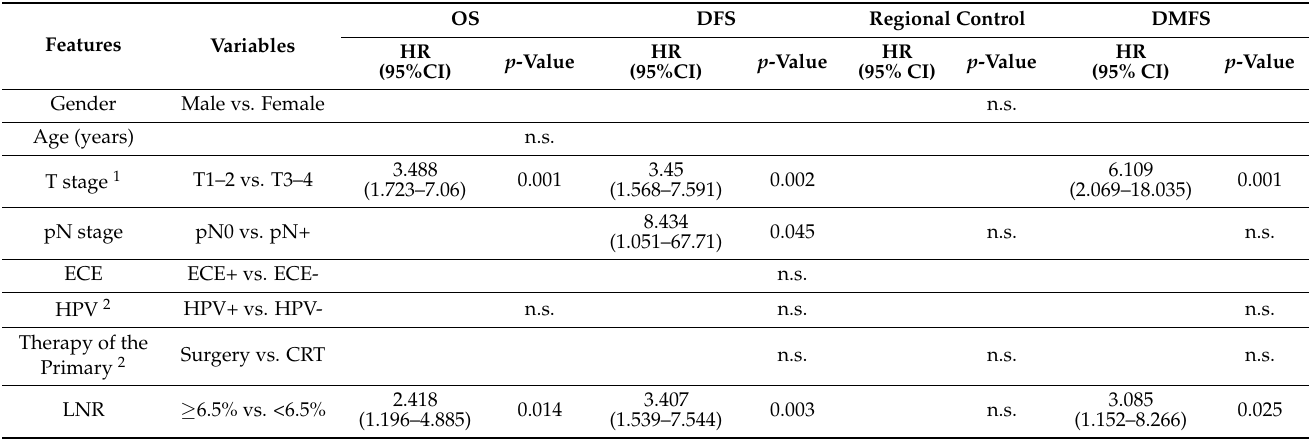
Table 3. Multivariate analysis of modified radical neck dissection factors associated with survival. n =